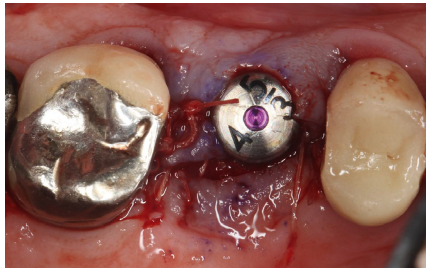
Figure 9: The implant was torqued in 35N/cm, and a healing abutment was placed. The site was sutured with three 5–0 chromic gut single-interrupted sutures.